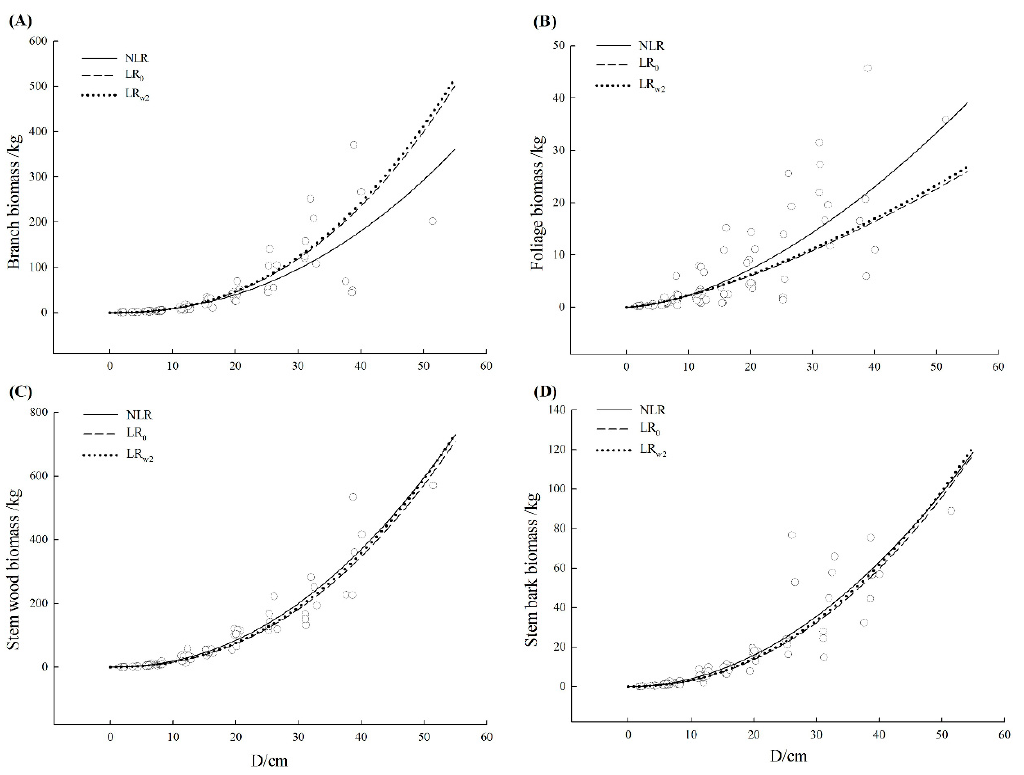
Figure 3. The curve fitted from nonlinear regression (NLR), uncorrected linear regression (LR 0 ) and corrected linear regression based on the weighted average of secondly basic correction factor from each component equation that is CF w2 ((LR w2 ) for Schima superba ( Schima superba Gardn. et Champ.). The scattered points were the observations from data. ( A )–( D ) represented branch, foliage, stem wood, and stem bark, respectively. The solid line represented the nonlinear regression model (NLR), the dashed line represented the uncorrected linear regression model (LR 0 ) and the dotted line represented the corrected linear regression based on the weighted average of secondly basic correction factor from each component equation that is CF w2 (LR w2 ).